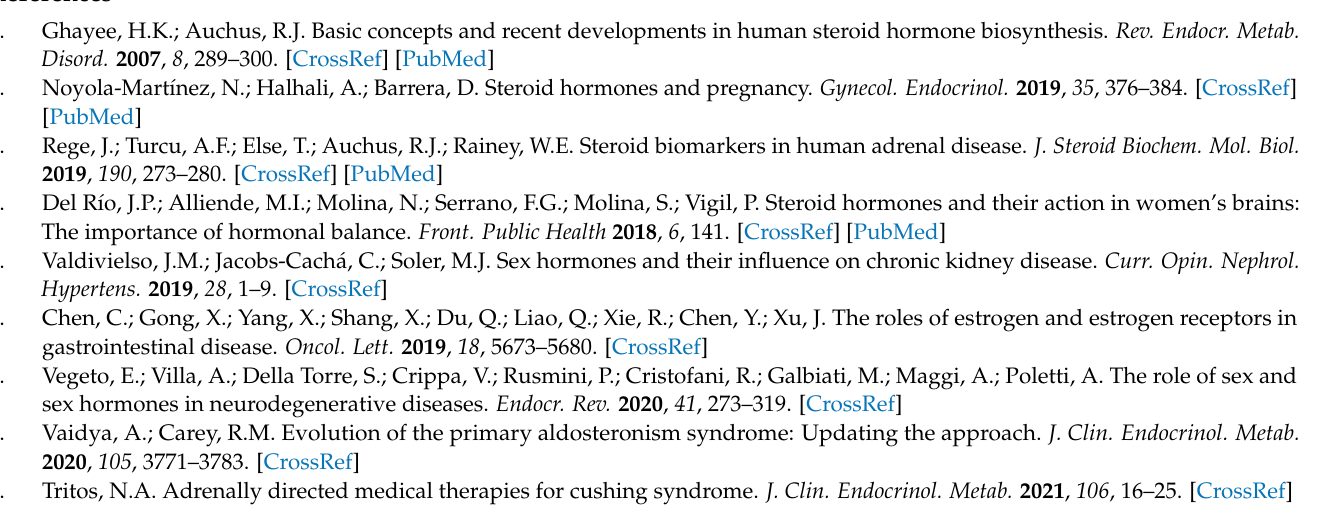
Table S3: The linear and limit of quantification in LC MS/MS for steroid hormones. Table S4: The reproducibility in in-tra- or inter-assays; Table S5: The average concentration of steroid hormones in AHs and